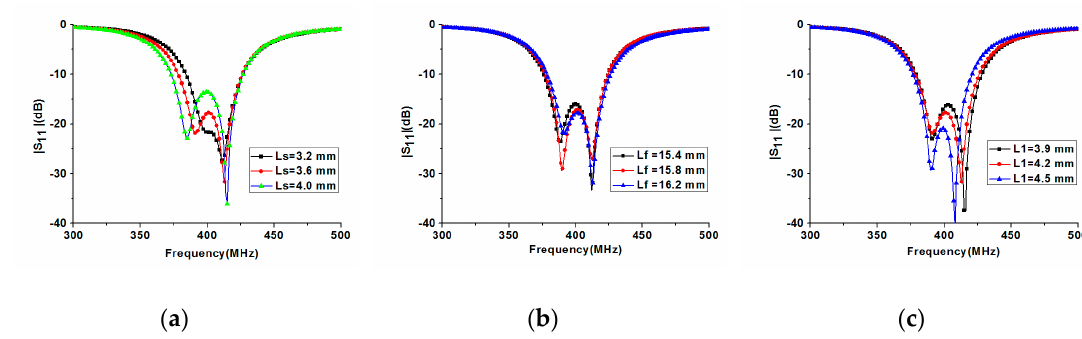
Figure 4. Comparison of | S 11 | of the proposed antenna with different geometric parameters: ( a ) short position L s ; ( b ) feed position L f ; and ( c ) tuned strip length L 1 .